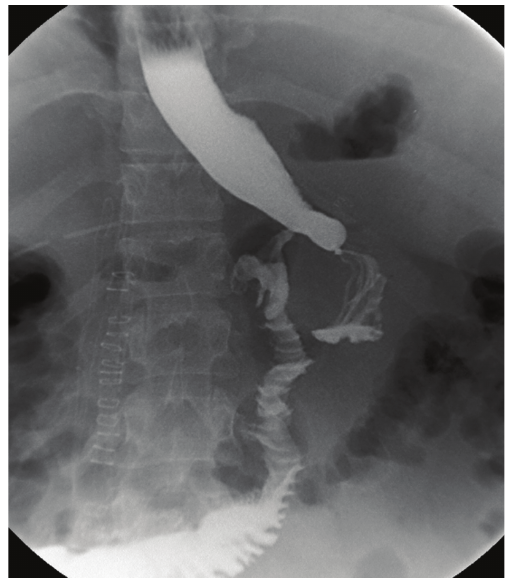
Figure 2: Traditional X-ray studies of a